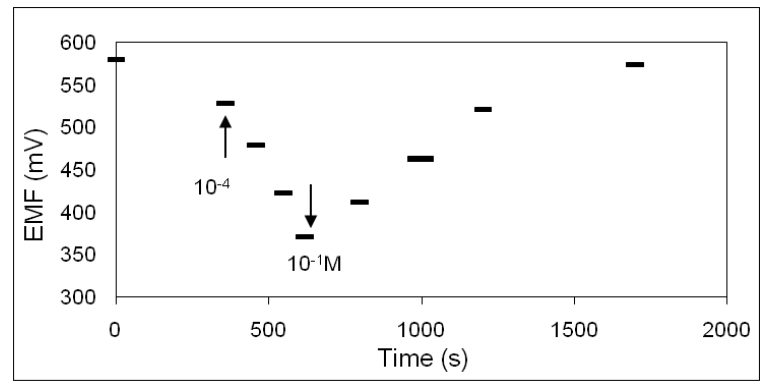
Figure 11. Dynamic potentiometric response to iodide and recovery time.